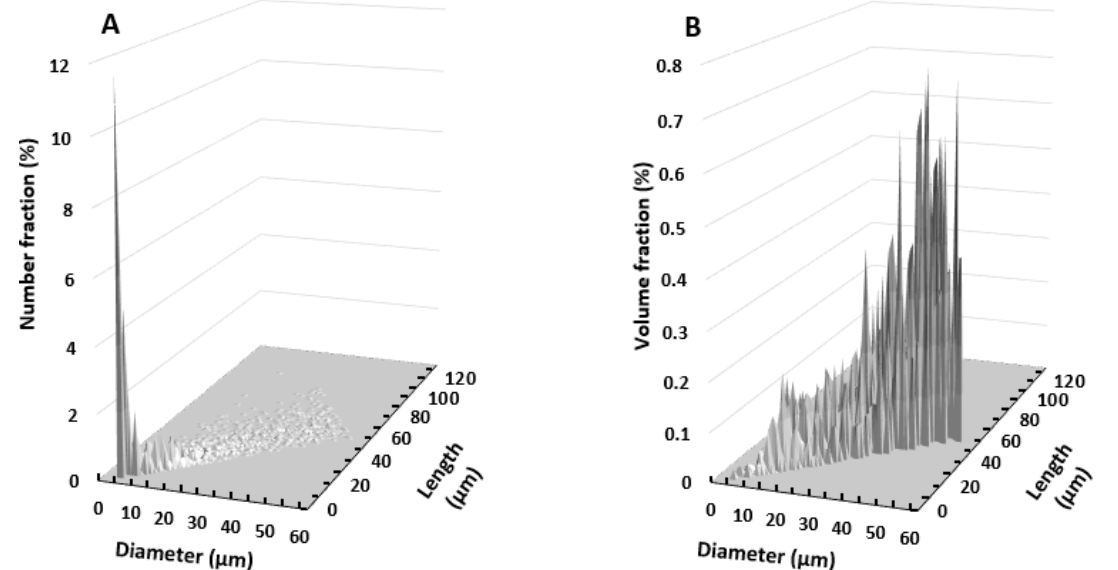
Figure 4. Two-dimensional (2D) particles size distribution in ( A ) number and ( B ) volume.